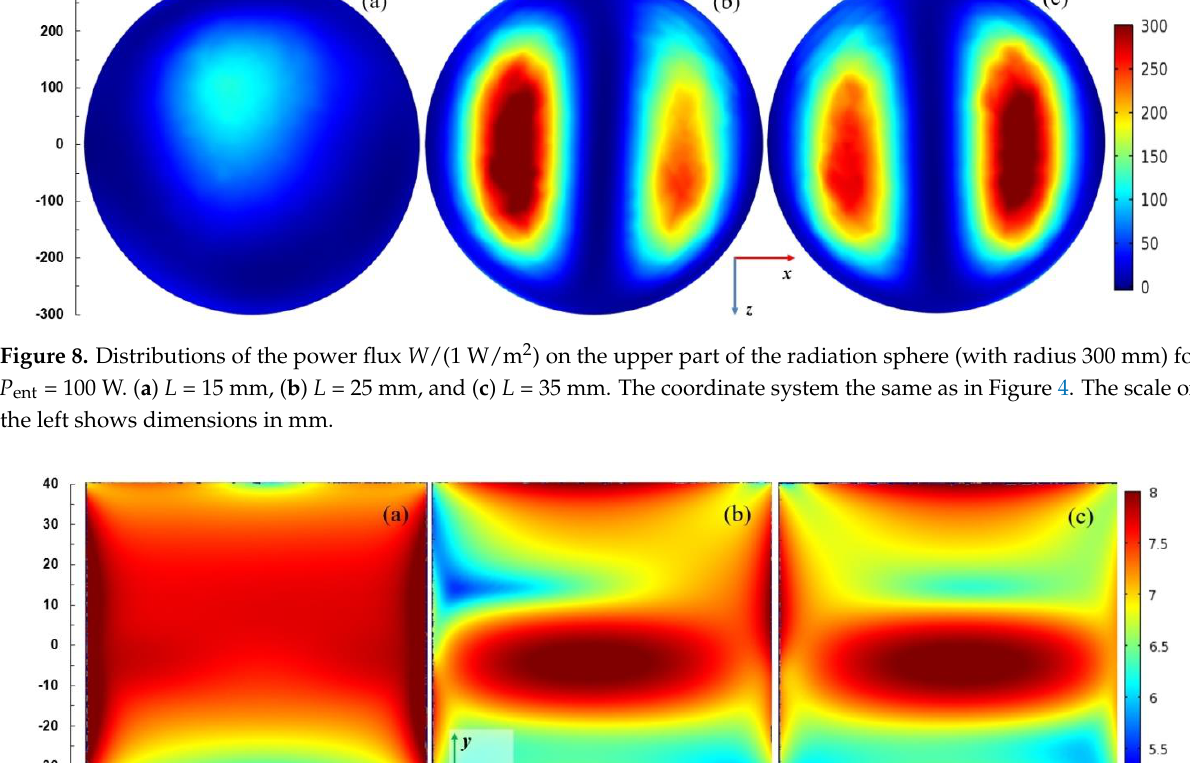
Figure 8. Distributions of the power flux W /(1 W/m 2 ) on the upper part of the radiation sphere (with radius 300 mm) for P ent = 100 W. ( a ) L = 15 mm, ( b ) L = 25 mm, and ( c ) L = 35 mm. The coordinate system the same as in Figure 4. The scale on the left shows dimensions in mm.